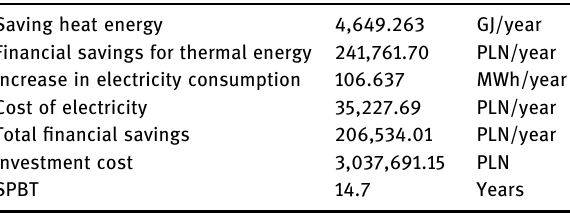
Table 7: Payback time for the heat recovery form the ice rink to the swimming pool ( source: own study